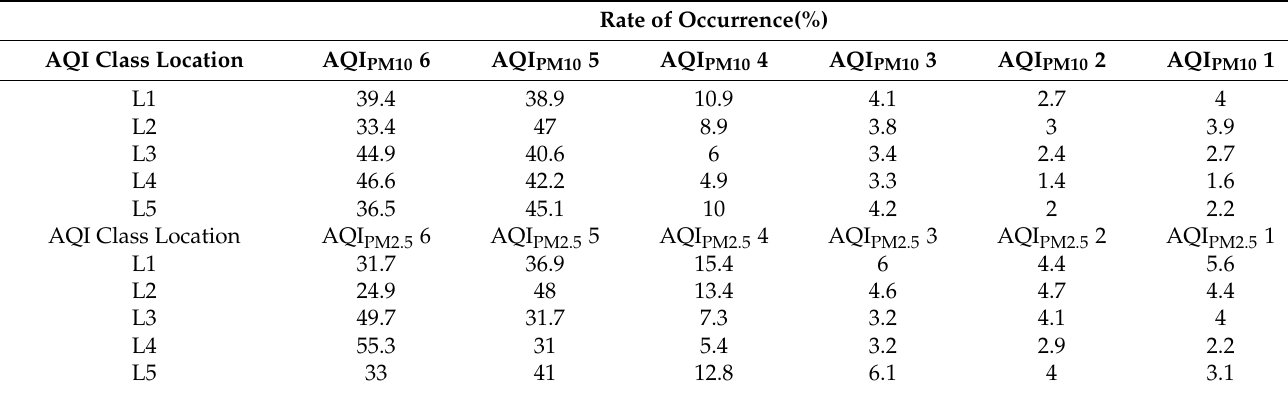
Table 7. Occurrence rates of AQI PM10 and AQI PM2.5 at locations L1–L5. Rate of